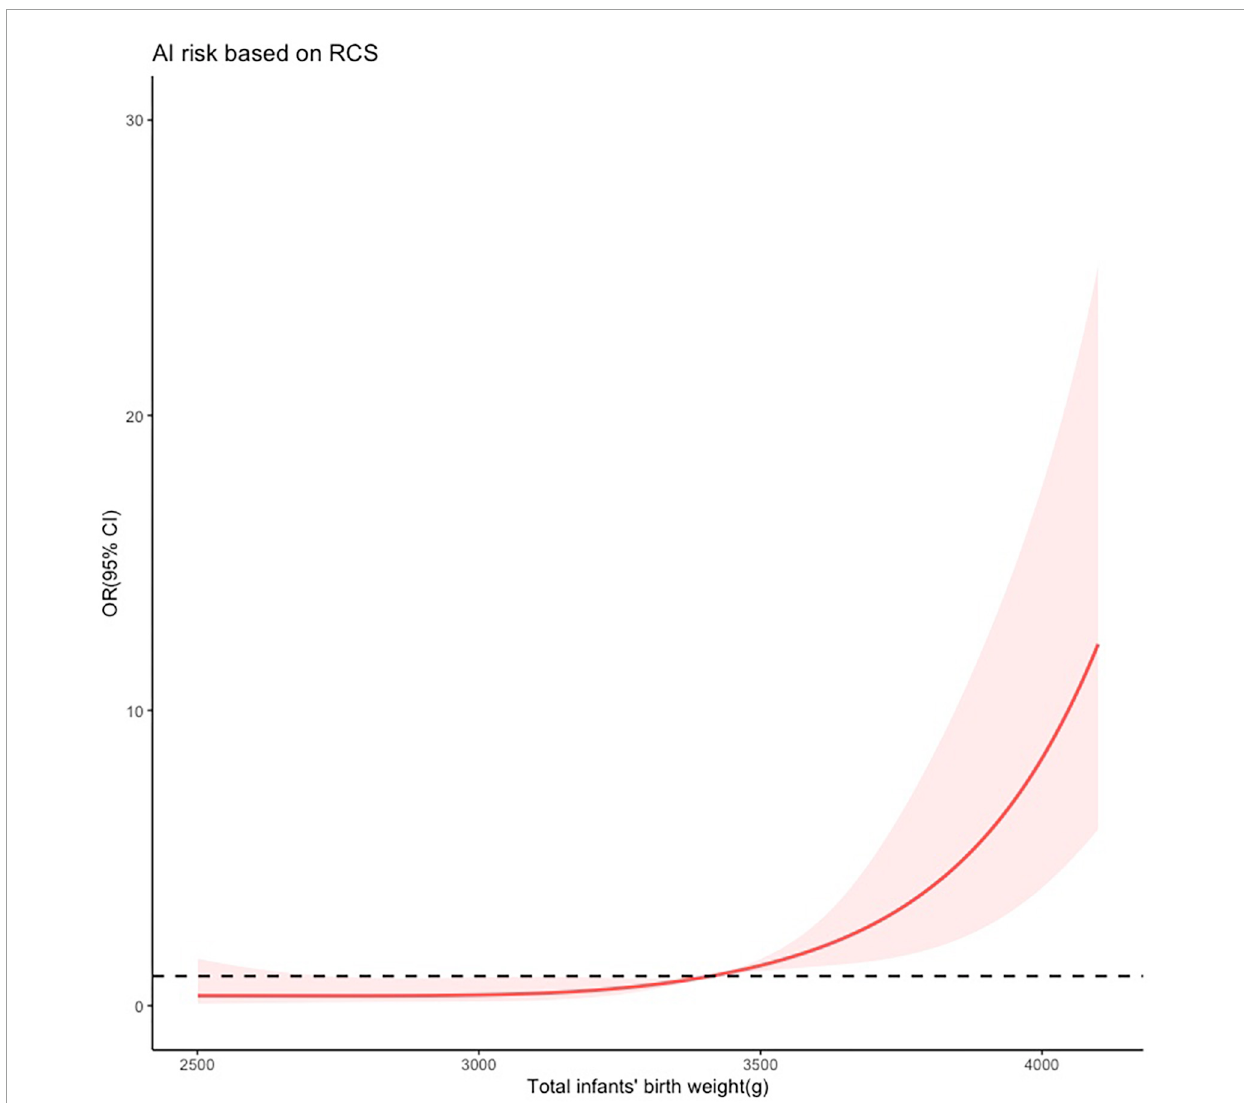
FIGURE4 Restricted cubic spline modeling of the relationship between total infants’ birth weight and the risk of anal incontinence (AI) 1 year after vaginal delivery. The odds ratios derived from a multivariate regression model is shown on the y-axis. The 95% confidence intervals (Cis) of the adjusted odds ratios are represented by the shaded area. The dotted line represents that the odds ratio is 1. The risk function demonstrates an inflection point at 3,400